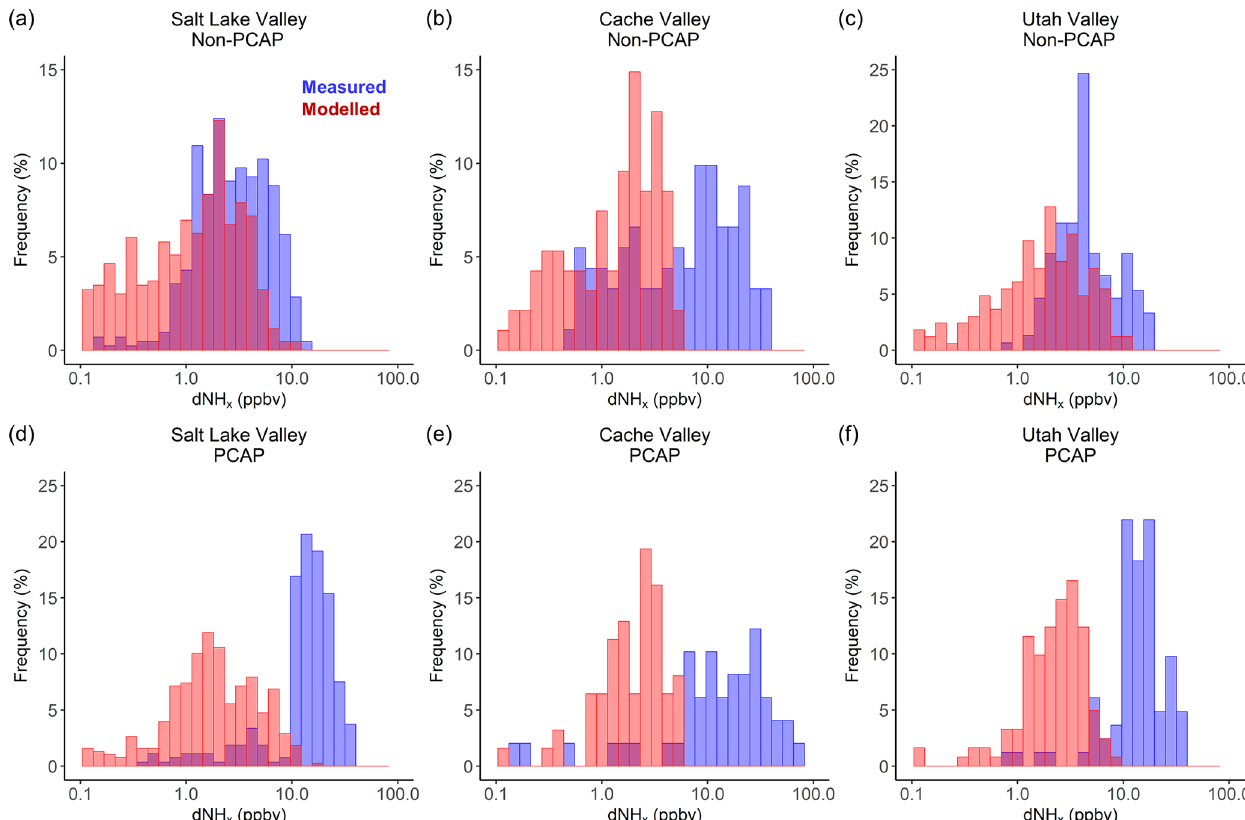
Figure 6. Frequency distribution of measured (blue) and modelled (red) NH x enhancements (dNH x ) for Salt Lake Valley, Cache Valley and Utah Valley on logarithmic scales for (a–c) non-PCAP and (d–f) PCAP